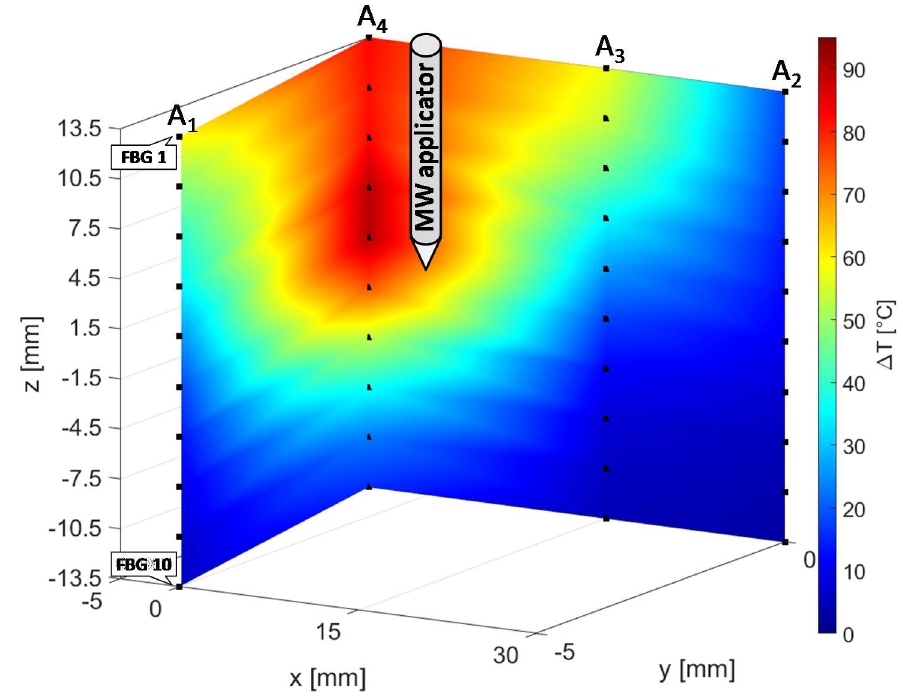
Figure 7. Temperature map in (cid:1877) (cid:3404) 0 and (cid:1876) (cid:3397) (cid:1877) (cid:3404) (cid:3398)5 planes; black dots indicate experimental values (not to